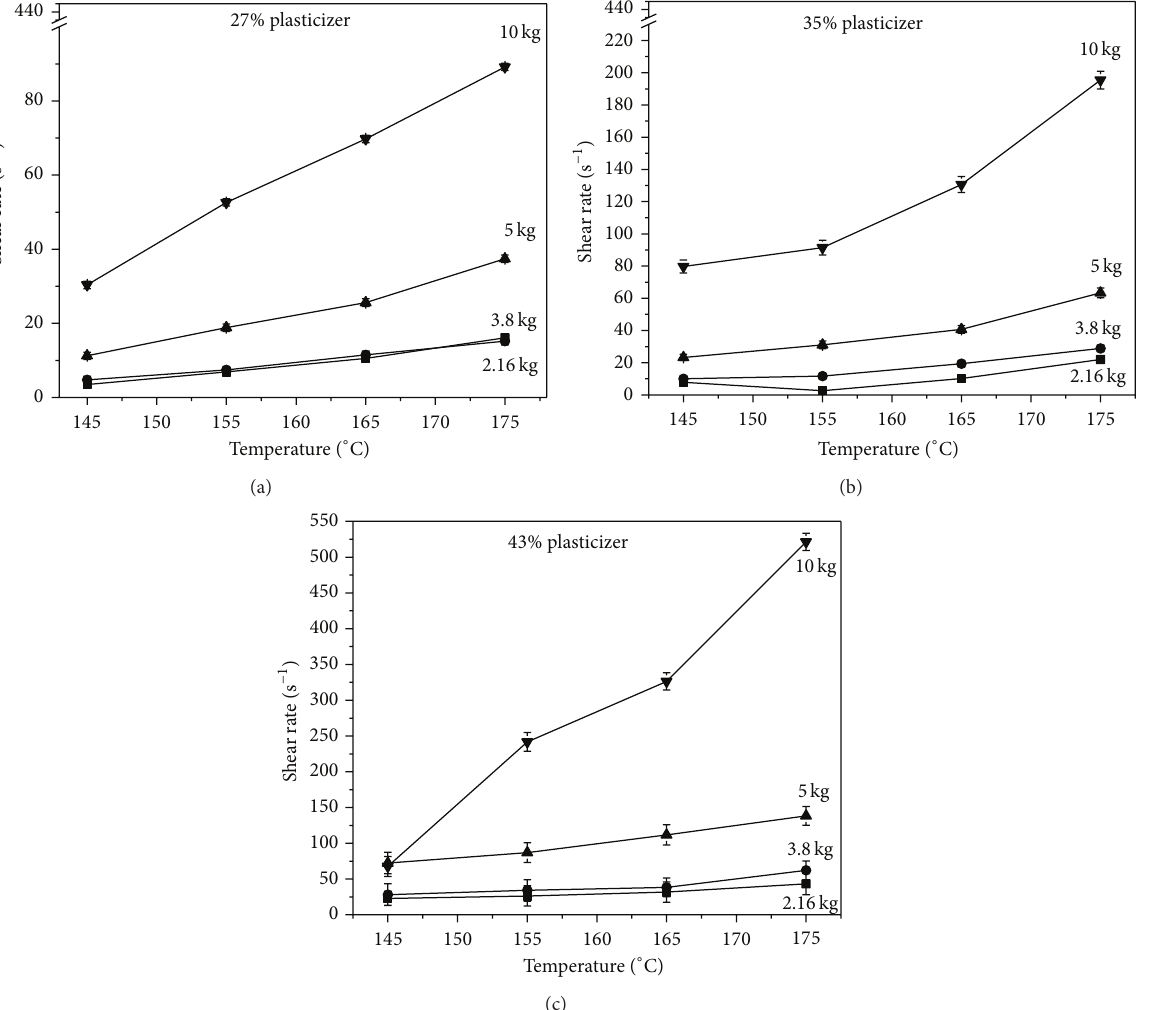
Figure 1: The dependence of the shear rate on the extrusion conditions and the plasticizing level ((a) 27%; (b) 35%; (c)